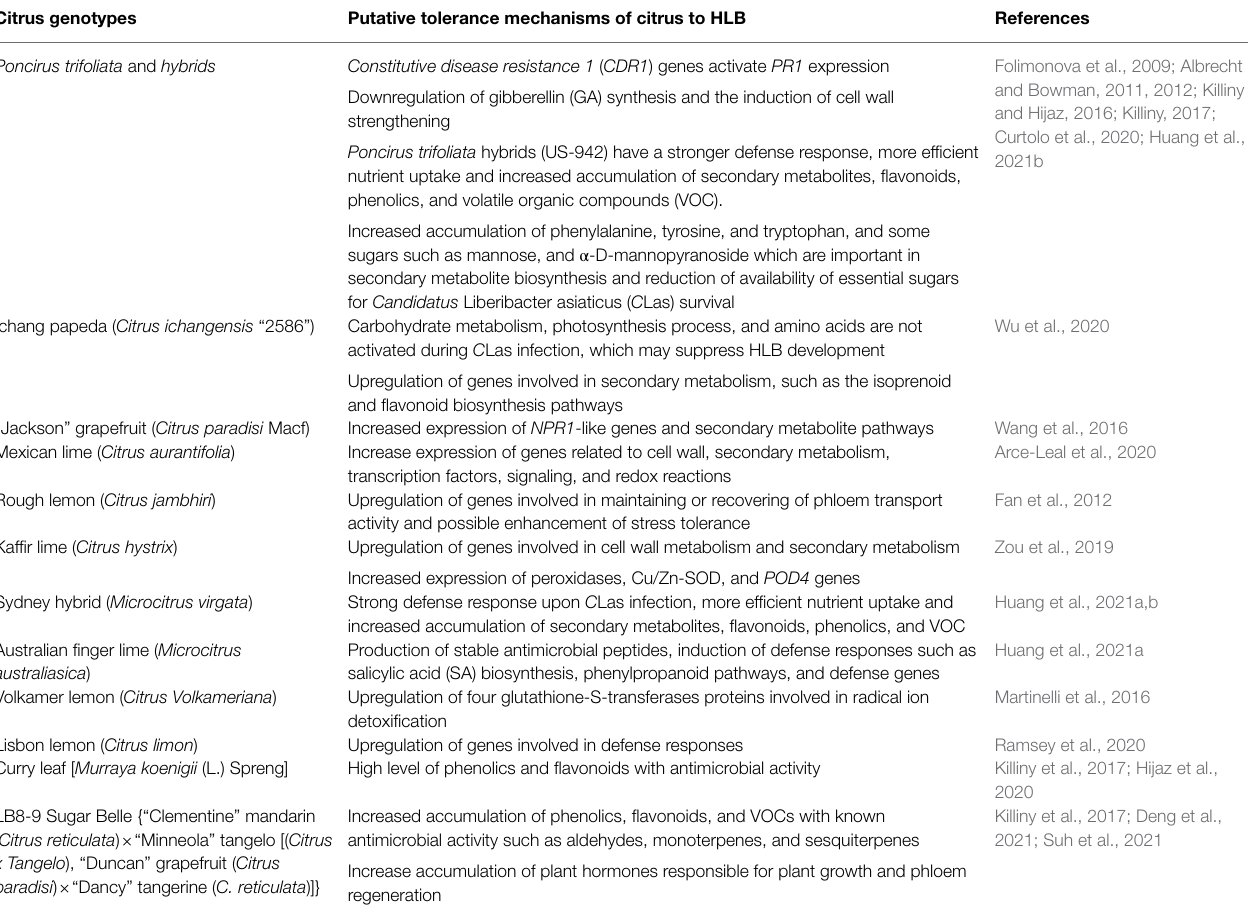
TABLE 2 | The mechanisms of Citrus Huanglongbing (HLB)-tolerant citrus elucidated by multi-omics